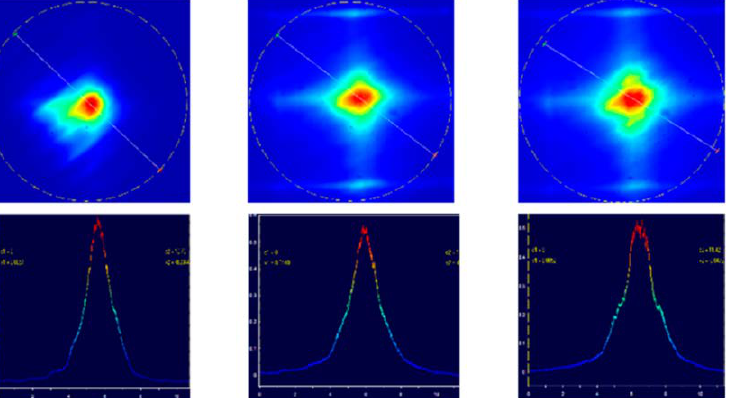
Figure 13. Far-field distribution of the Ti:Sapphire laser radiation with MLA pump. Two-dimensional patterns and the appropriate intensity profiles were recorded at the focal plane of 800 mm lens at different levels of pump fluence: left—W = 1 a. u.; middle—W = 1.7 a. u.; right—W = 2.9 a. u. Horizontal scale of the profiles is 1 mm per division. Reprinted with permission from ref. [18]. Copyright 2019 © The Optical